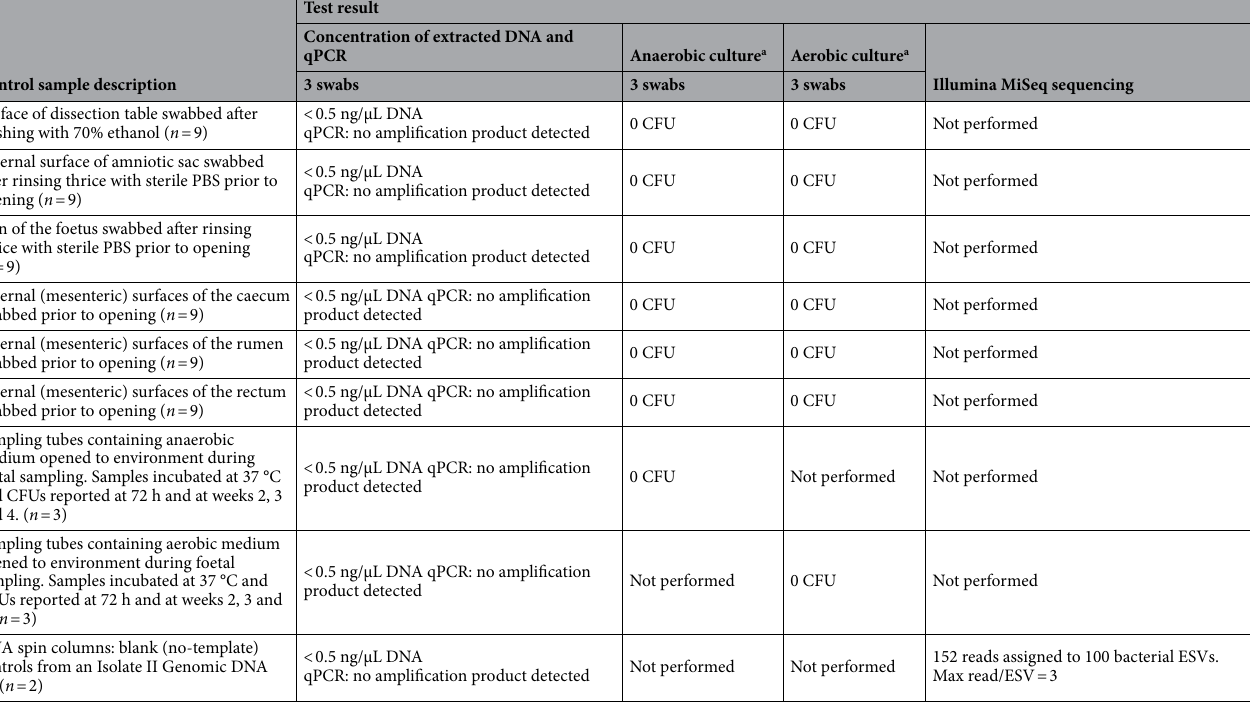
Table 1. Description of control samples and test results per foetus ( n = 12). CFU colony forming unit, ESV exact sequence variant, PBS phosphate-buffered saline. a Swabs incubated at 37 °C and CFUs reported at 72 h, then stored at 4 °C and CFUs reported for up to 4